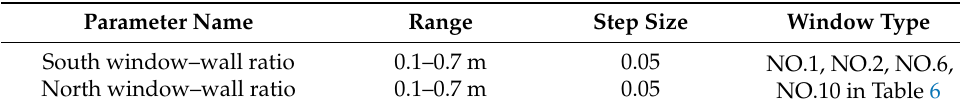
Table 8. Parameter settings for window–wall